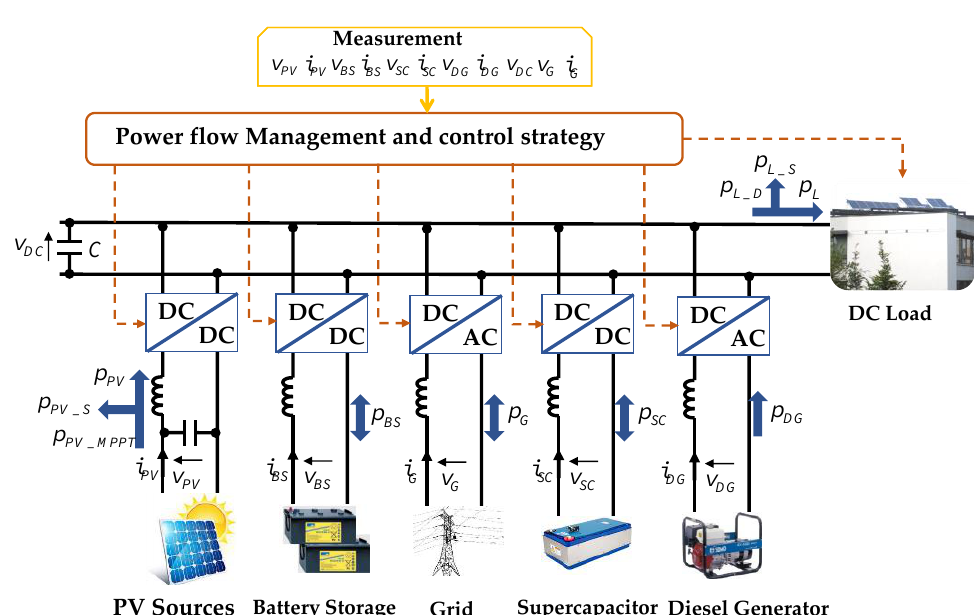
Figure 1. Overview of full direct current (DC) microgrid.